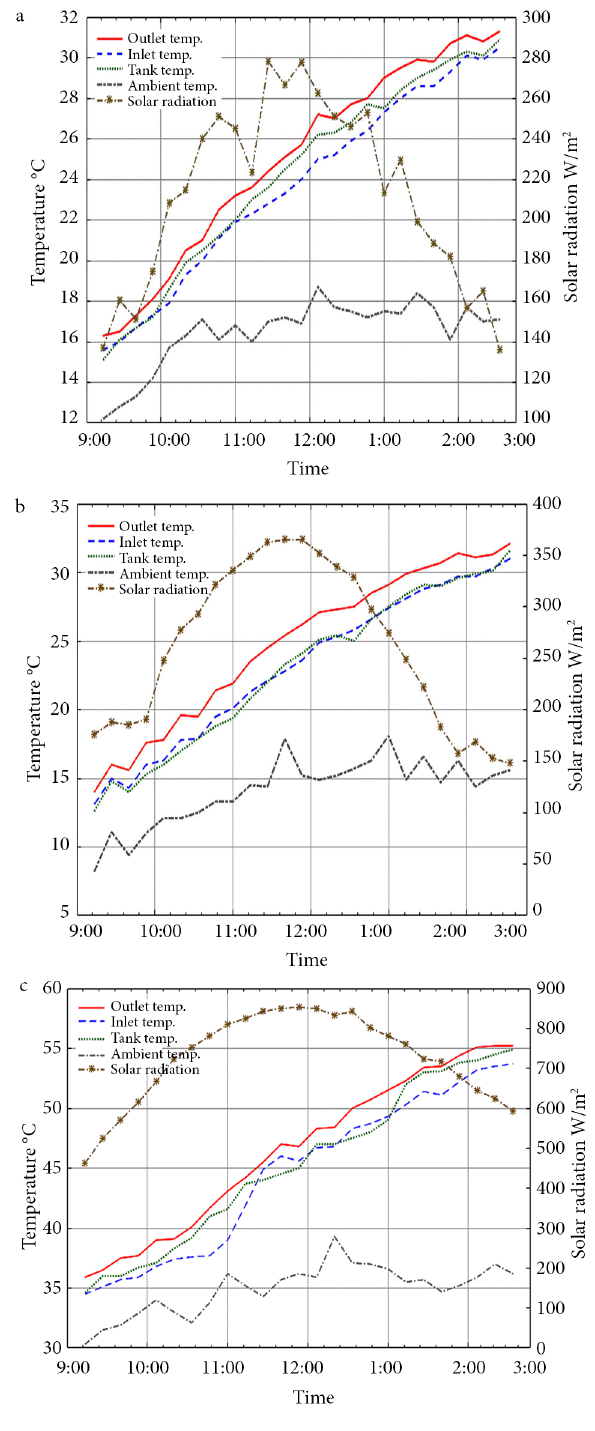
Figure 8. measured outlet, inlet, storage tank, ambient temperature and solar radiation on: a − Nov. 28 th 2018, b − Feb. 3 rd 2019, c − May 16 th 2019